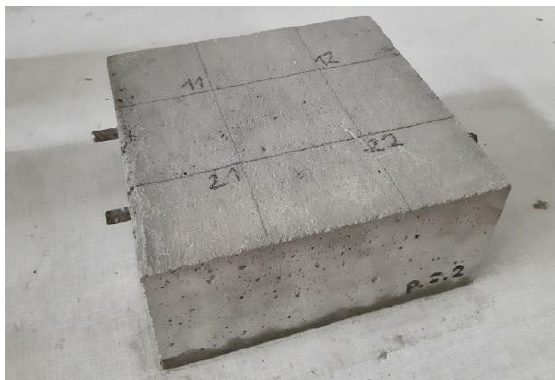
Figure 1. A photo of one of the research specimens.